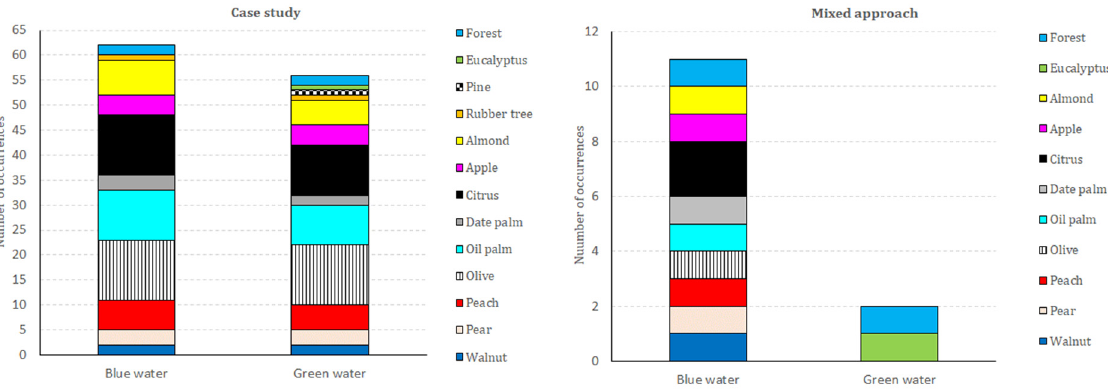
Figure 7. Tree types and WF components for the case studies and mixed approaches. Globally, 56% of the occurrences refer to the blue water component and 44% to the green water component, which demonstrates that green water is often excluded from